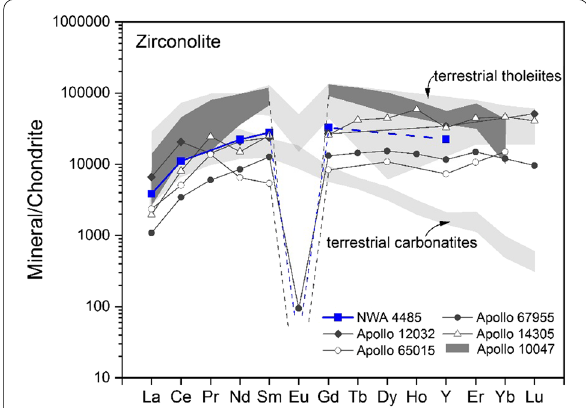
Fig. 2 Chondrite-normalized REE pattern of zirconolite from NWA 4485. It is compared with Apollo lunar zirconolites (Norman and Nemchin 2014; Rasmussen et al. 2008; Seddio et al. 2013) and terrestrial grains from tholeiites (Rasmussen et al. 2008) and carbonatites (Wu et al. 2010). The Eu composition in our grain is predicted to be lower than 100 CI based on Apollo lunar zirconolite × studies